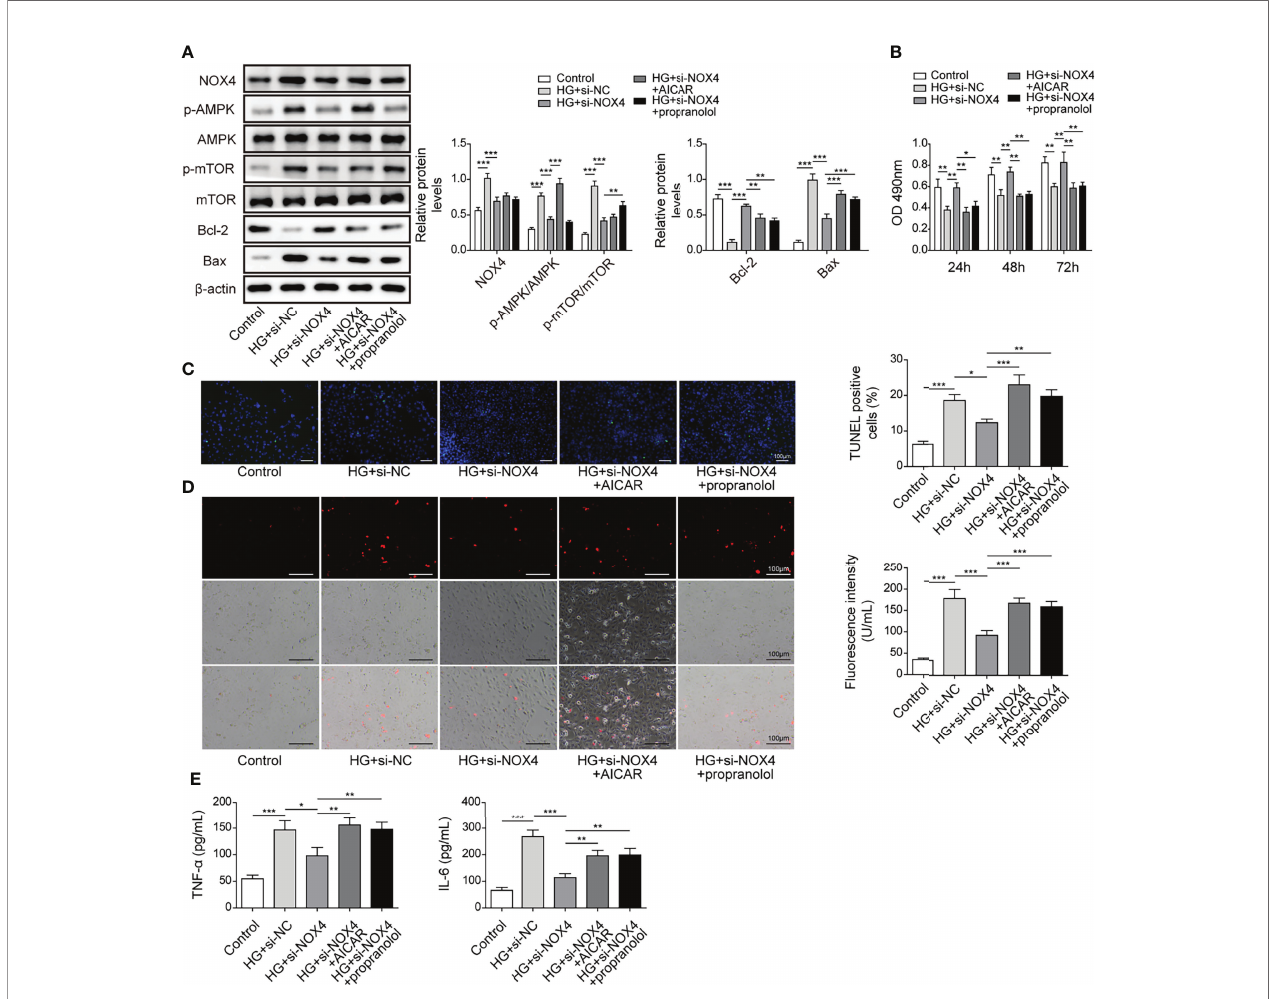
FIGURE 8 | Knockdown of Nox4 relieved HG-induced injury by suppressing the AMPK/mTOR signaling. HK-2 cells were transfected with si-Nox4 and treated with HG, HG + AICAR or HG + propranolol. (A) Protein levels of Nox4, p-AMPK, AMPK, p-mTOR, mTOR, Bcl-2 and Bax (n=4). (B) Cell viability was examined by MTT assays (n=4). (C) TUNEL staining (TUNEL, green. Scale bar=100 µM) were examined. The nucleus was stained with DAPI (blue). (D) Cellular ROS levels were examined by a fl uorometric ROS sensor (red, n=4.Scale bar=100 µM). (E) Secretion of TNF- a and IL-6 (n=4) into culture supernatants. * P < 0.05, ** P < 0.01 and *** P <